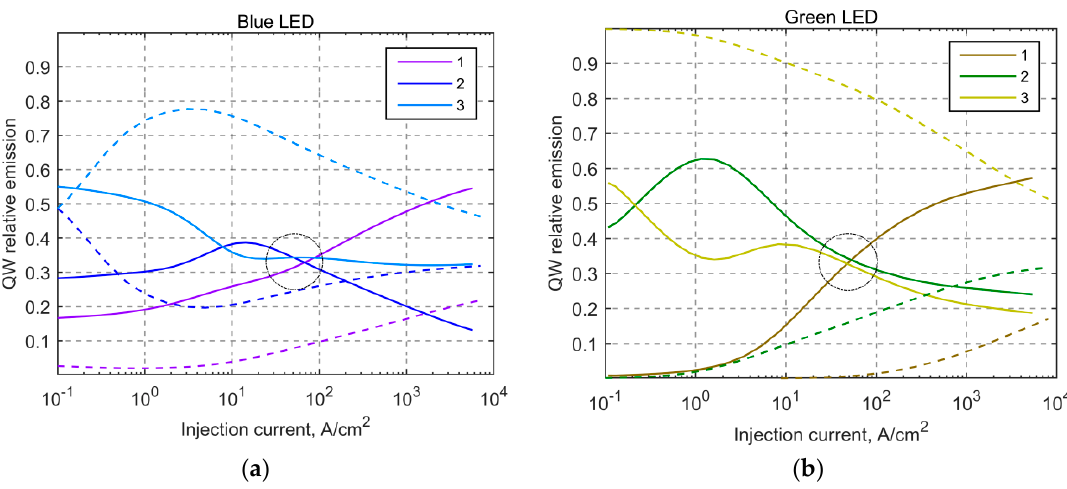
Figure 3. Injection dependence of multiple-quantum-well (MQW) relative optical emission in ( a ) blue-emitting ( b ) and green-emitting LEDs with plain-barrier (dashed lines) and optimized IBL (solid lines) active region designs. Quantum wells are counted from n-side of the active region. The area of the uniform MQW injection is encircled.